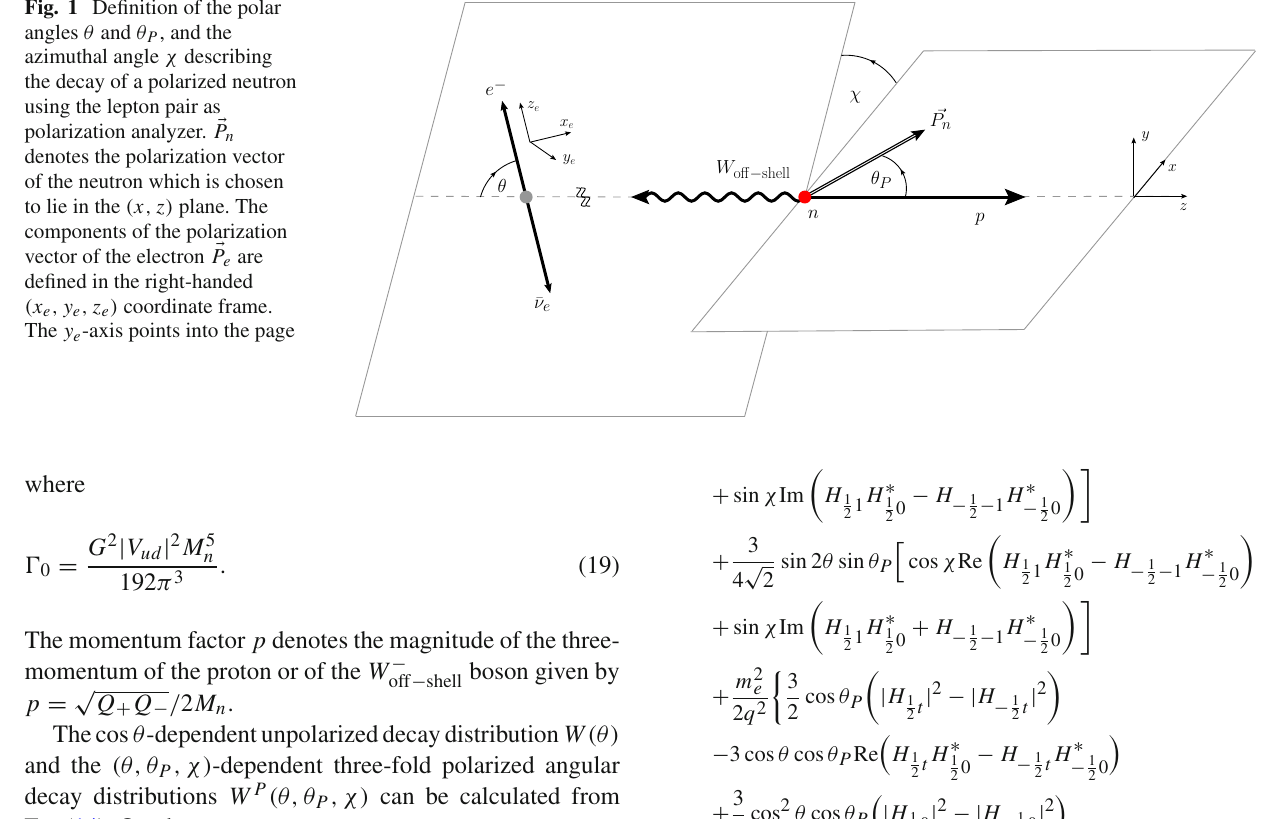
− boson given by off − shell